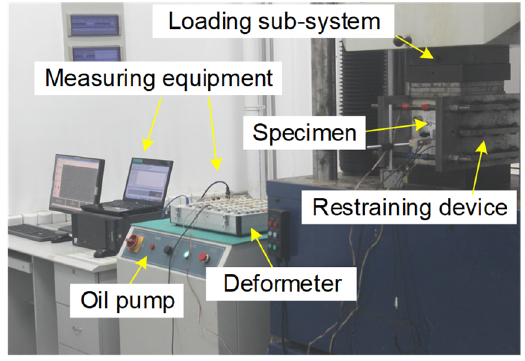
Figure 2. Experimental system.